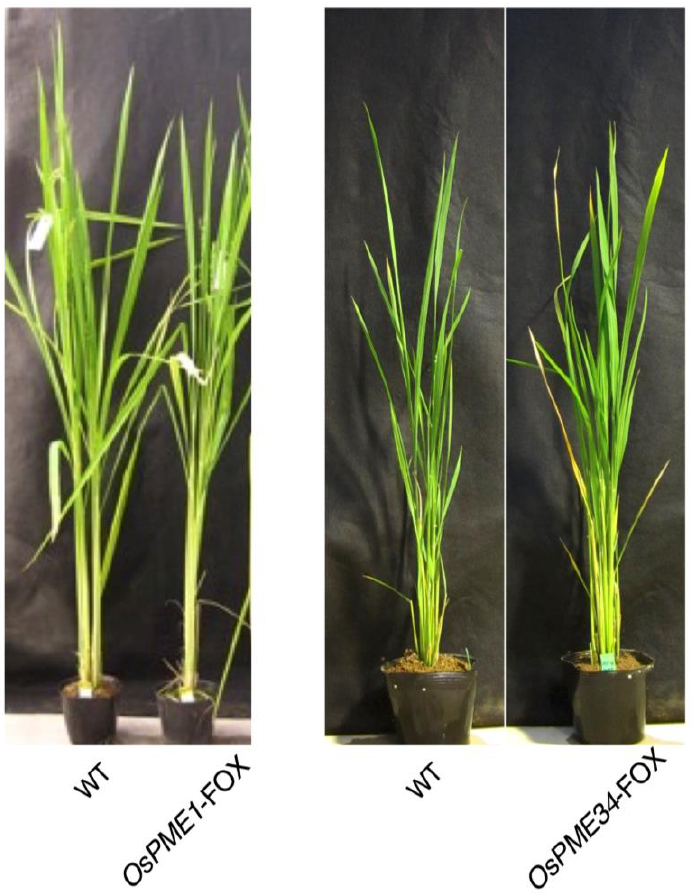
Figure 3. Vegetative phenotypes of OsPME1 -FOX and OsPME34 -FOX compared with WT plants). 60 days after seeding.